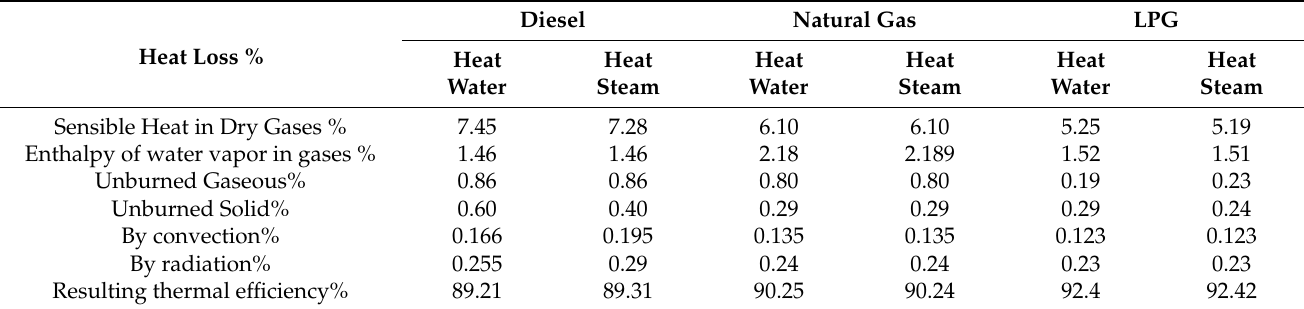
Table 3. Distribution of losses and thermal efficiencies (for